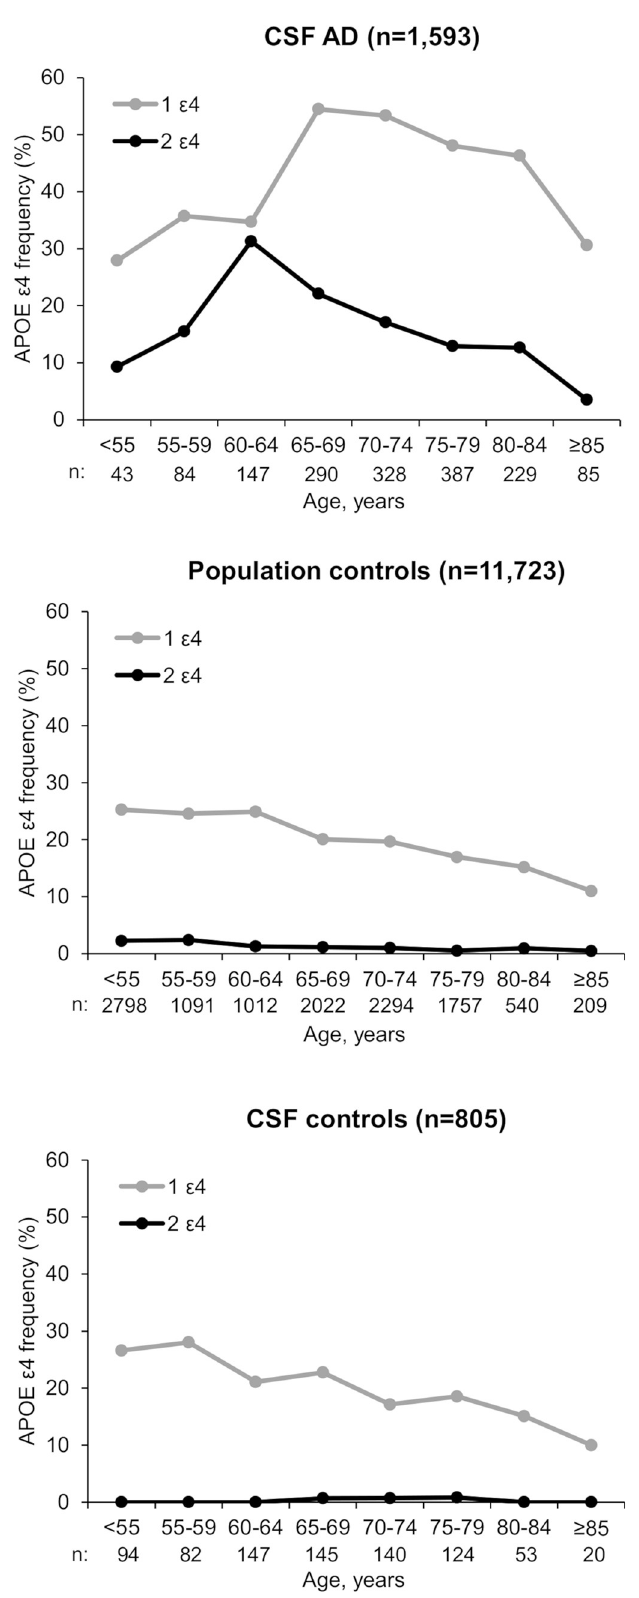
Fig 2. APOE ε 4 prevalence in CSF AD cases and population and CSF controls as a function of age group. AD, Alzheimer disease; APOE , apolipoprotein E; CSF, cerebrospinal fluid. https://doi.org/10.1371/journal.pmed.1003289.g002 PLOS Medicine| https://doi.org/10.1371/journal.pmed.1003289 August 20,